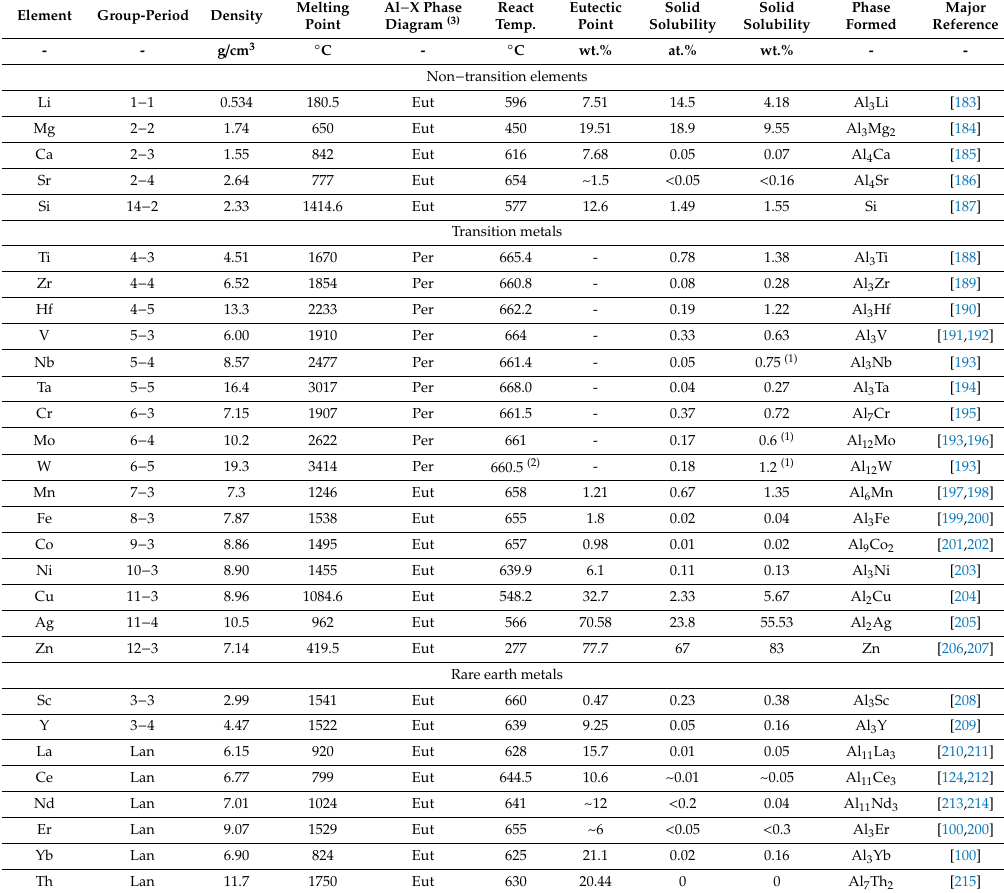
Table A4. Phase diagram data for alloying elements with aluminum. Element Group-Period Density